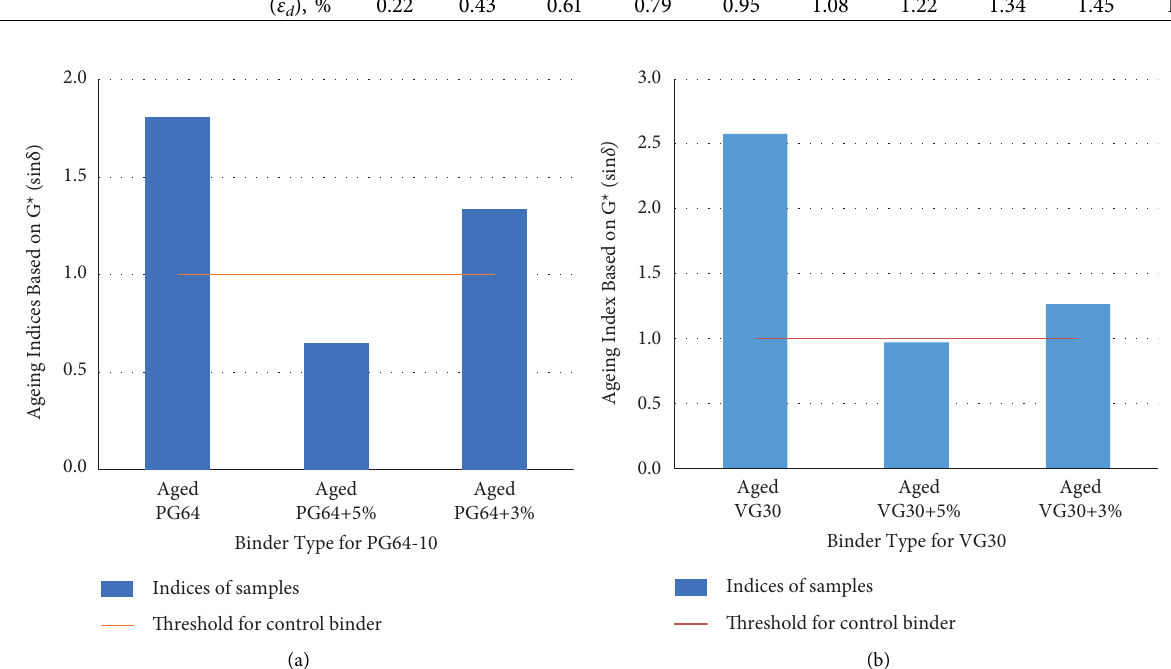
Figure 7: Ageing indices ratio for bitumen binders based on rheological parameter. (a) Binder type for PG64-10. (b) Binder type for VG30.